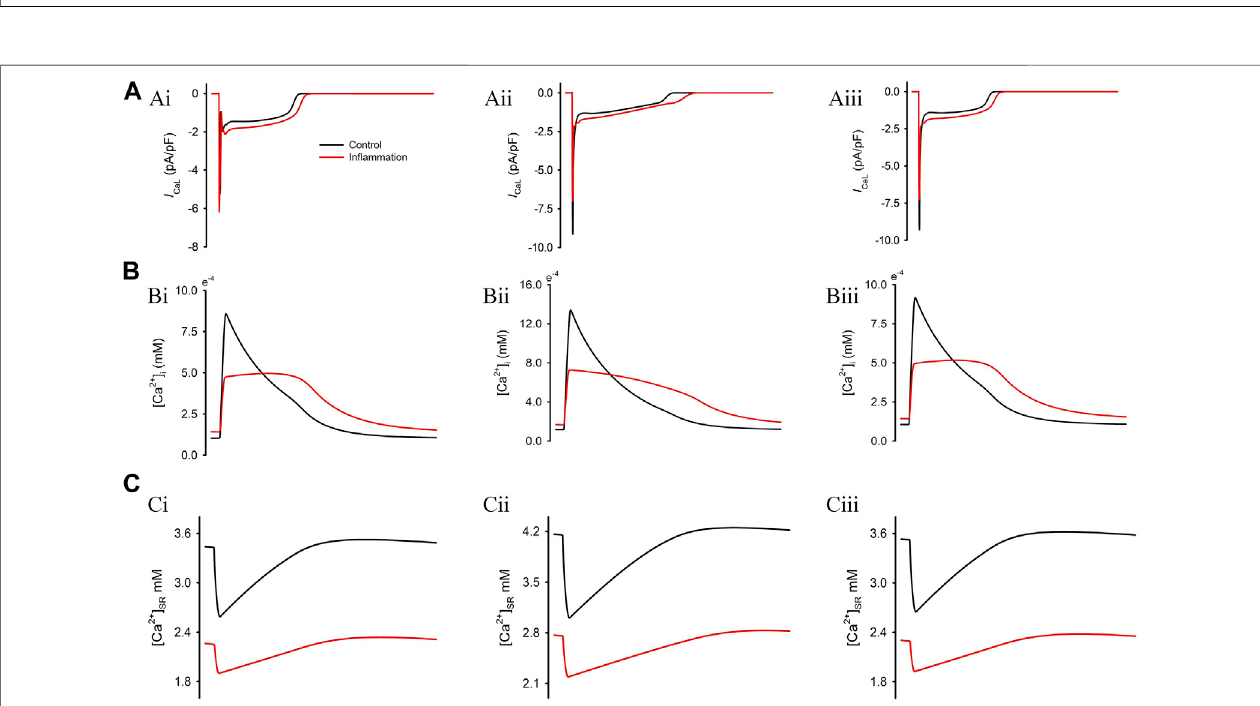
FIGURE 2 | Simulation results of the combined effects of three in fl ammatory cytokines on calcium handling. Corresponding pro fi les for I CaL (A) and the concentration of Ca 2+ in the cytosol (B) and sarcoplasmic reticulum (C) .